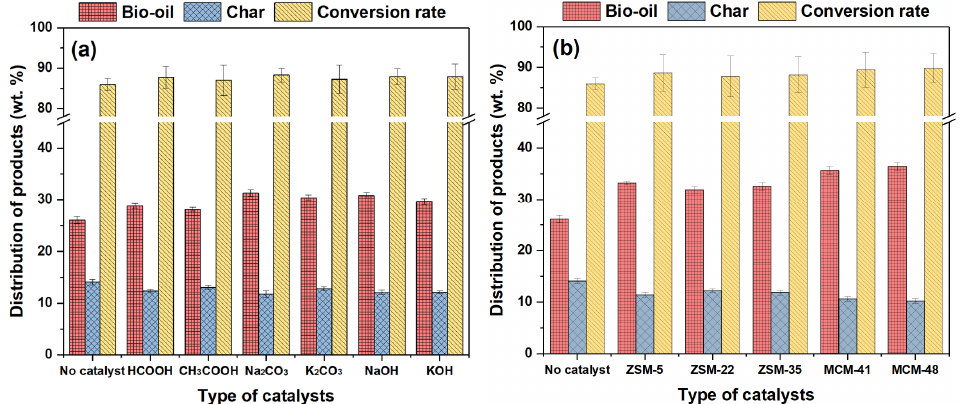
Figure 1. Influence of catalyst type on distribution of hydrothermal liquefaction products: ( a ) homogeneous catalysis, ( b ) heterogeneous catalysis.